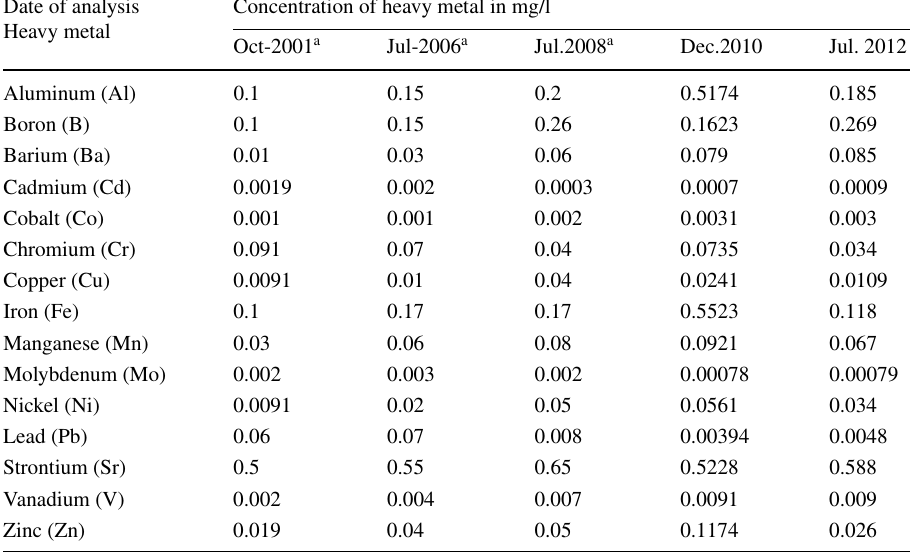
Table 3 Concentration of chemical inorganic pollutants (mg/l) resulted from the analyzed samples of wastewater of pond no. 1